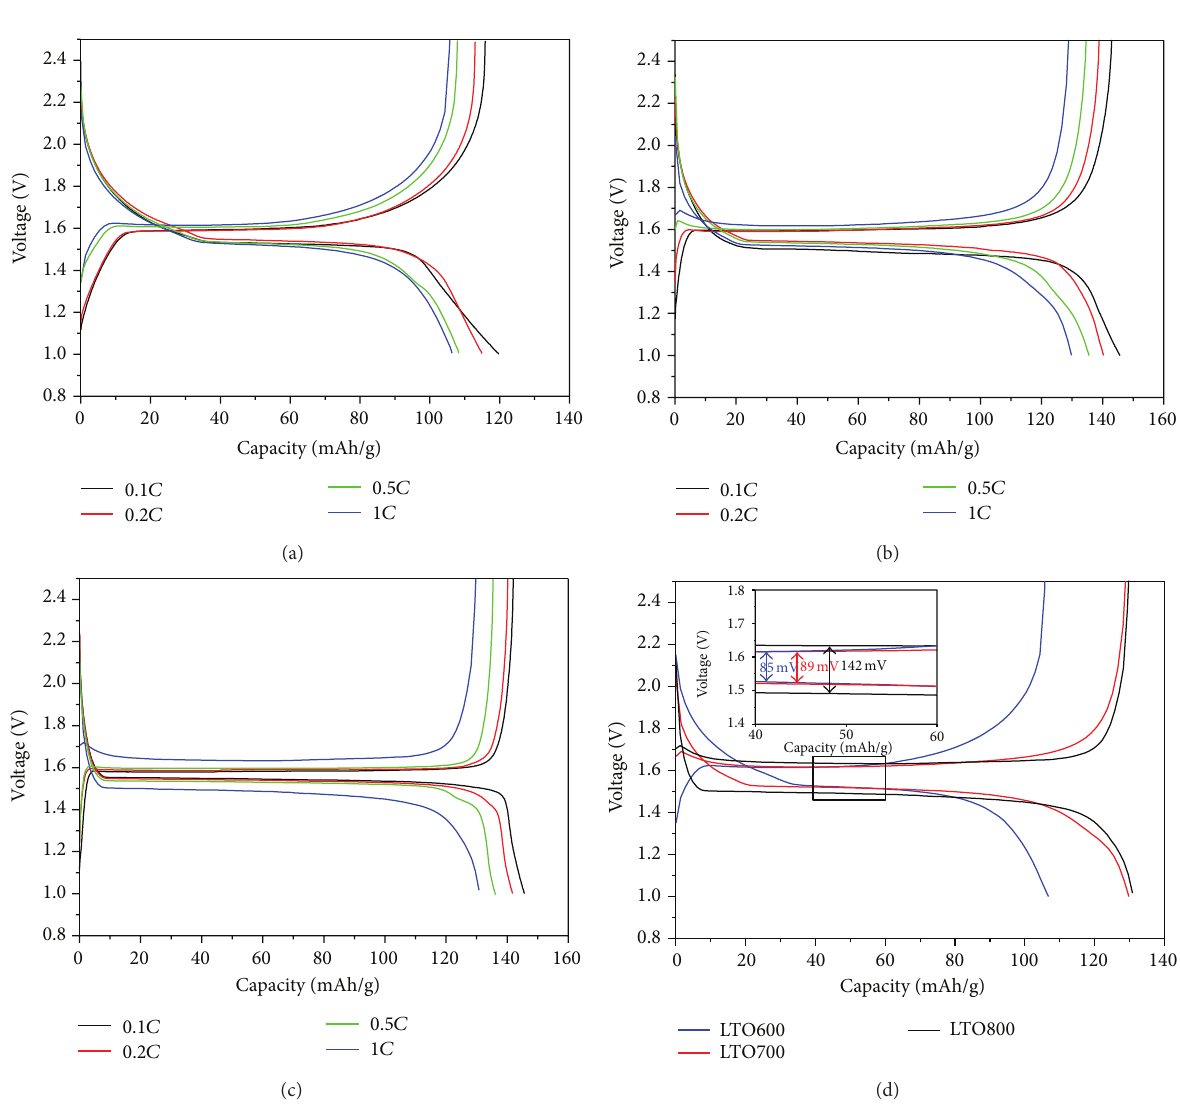
Figure 7: The charge-discharge curves of LTO samples (a) LTO600, (b) LTO700, and (c) LTO800 and (d) regional amplification at plateau voltage of 1 C